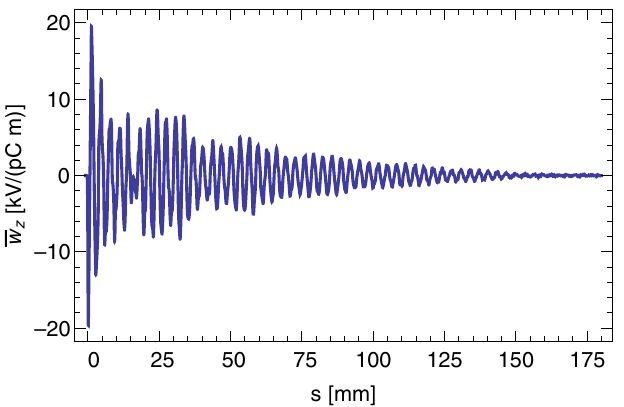
FIG. 10. The numerically obtained, longitudinal wake for the beam moving on axis of a double plate dechirper. Here half aperture a ¼ 0 . 7 mm and dechirper length L ¼ 135 mm; the ¼ 100 μ m. Note that the wake driving bunch is Gaussian with σ z is normalized to structure